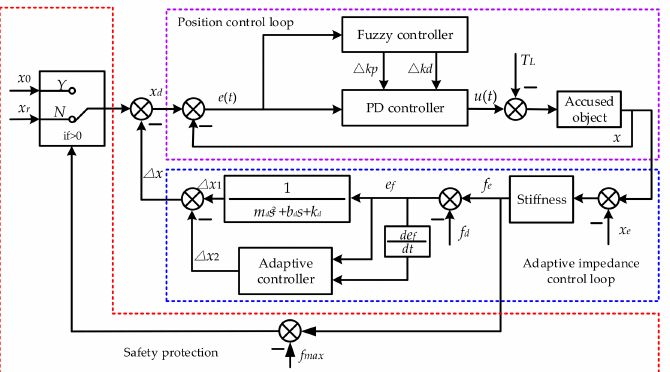
Figure 10. Control strategy of the EFRR: adaptive impedance control strategy based on fuzzy PD.